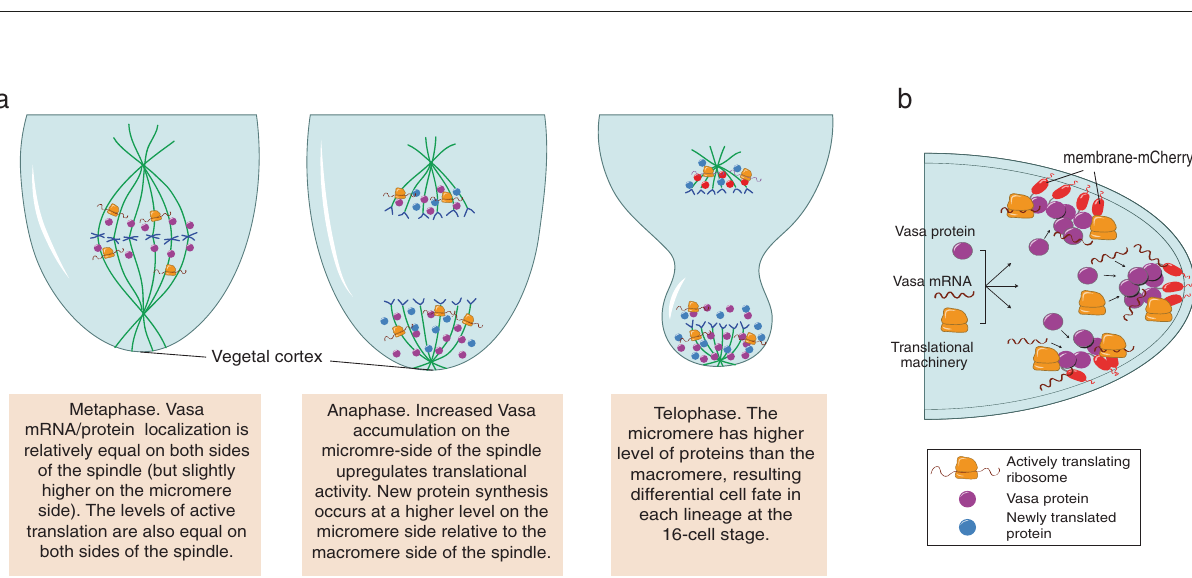
Fig. 7 Optogenetic disruption of Vasa localization on the spindle during asymmetric cell division altered localized translation and cell fate of the micromeres. a – d Upon blue light irradiation, Vasa-mCherry-LOV was recruited to actin, resulting in Vasa-less micromeres at the 16-cell stage in the experimental group. A level of translation was detected by FIAsH-EDT 2 at the 16-cell stage and was increased in the micromere-side of the spindle in the control group ( a and b ) whereas decreased in that of the experimental group ( c and d ). A whole Z-section of the cell of interest (0.44 μ m per slice; ~90 slices in total) was imaged and analyzed every 1-min and presented as a maximum 2D-projection. A bright green spot (*) is a non-speci fi c debris that tends to fl uoresce under the microscope. Each experiment was repeated at least three times and the measurement results of two other embryos are shown in Supplementary Fig. S10f. e , f Localization of β -catenin-GFP was tracked by time-lapse imaging of every 15 min for ~5 h after activation (approximately, ~12 hpf). In controls, GFP- β -catenin enriched into the vegetal most cells ( e , arrows), whereas its localization became uniform or random in the experimental groups ( f , arrows). Arrowheads indicate ectopic localization of GFP- β -catenin. A whole Z-section of the embryo of interest (1 μ m per slice; ~50 slices in total) was imaged and is presented as a maximum 2D-projection. The embryos were lightly squashed to completely immobilize during imaging. Therefore, the embryos that successfully formed micromeres under this condition were selected for the analysis and the embryos in a similar angle were compared between control and experimental groups in this study. These experiments were performed at least three independent times. All Scale bars = 10 μ m. Source data are provided as a Source Data fi le.